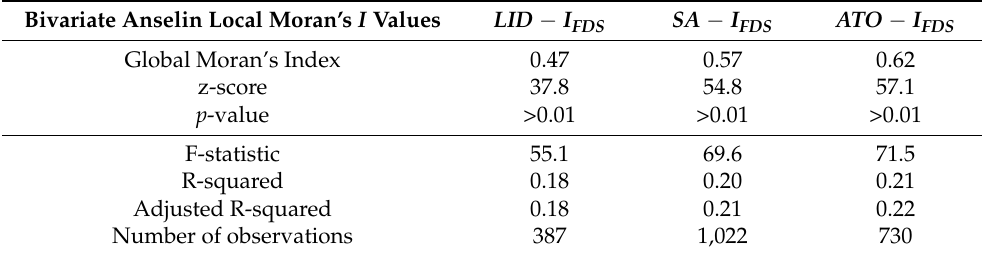
Table 5. Bivariate Anselin Local Moran’s I statistics for spatial autocorrelation between the I FDS global coastal vulnerability index and the three GIS anthropization indices LID , SA , and ATO . Bivariate Anselin Local Moran’s I Values LID − I FDS